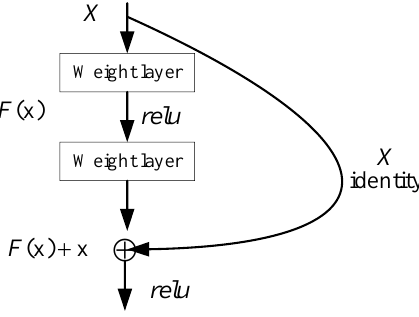
Figure 3. ResNet network structure diagram.